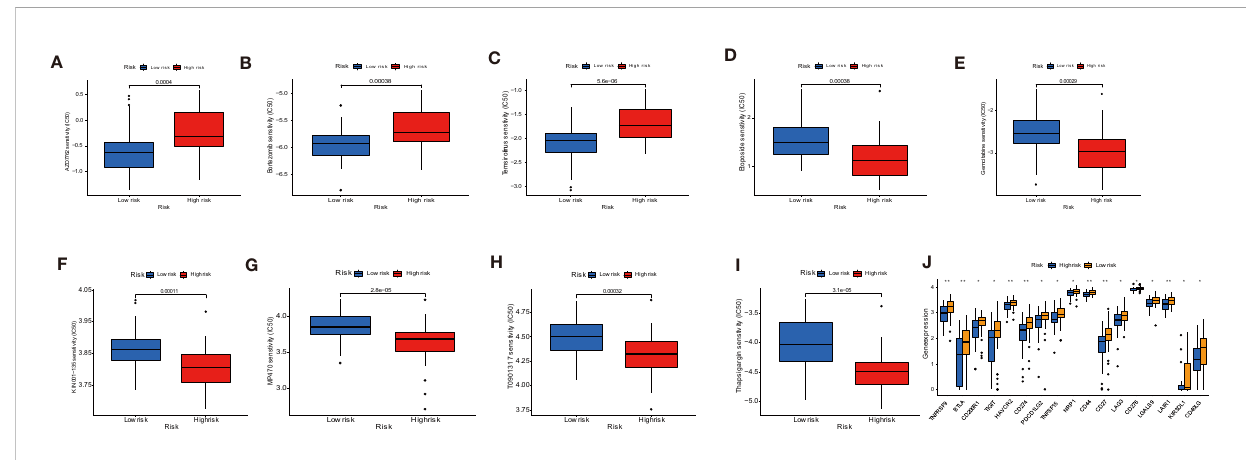
FIGURE 12 Drug sensitivity analysis and immune checkpoint molecules expression analysis. (A – I) Sensitivity performance of 9 drugs in the high-risk and low-risk groups. (J) Differential expression of immune checkpoint genes between low- and high-risk groups. * P < 0.05, ** P <